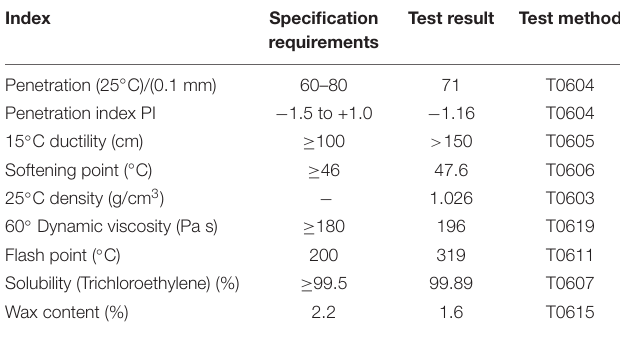
TABLE 1 | Test results of technical indices of base asphalt.